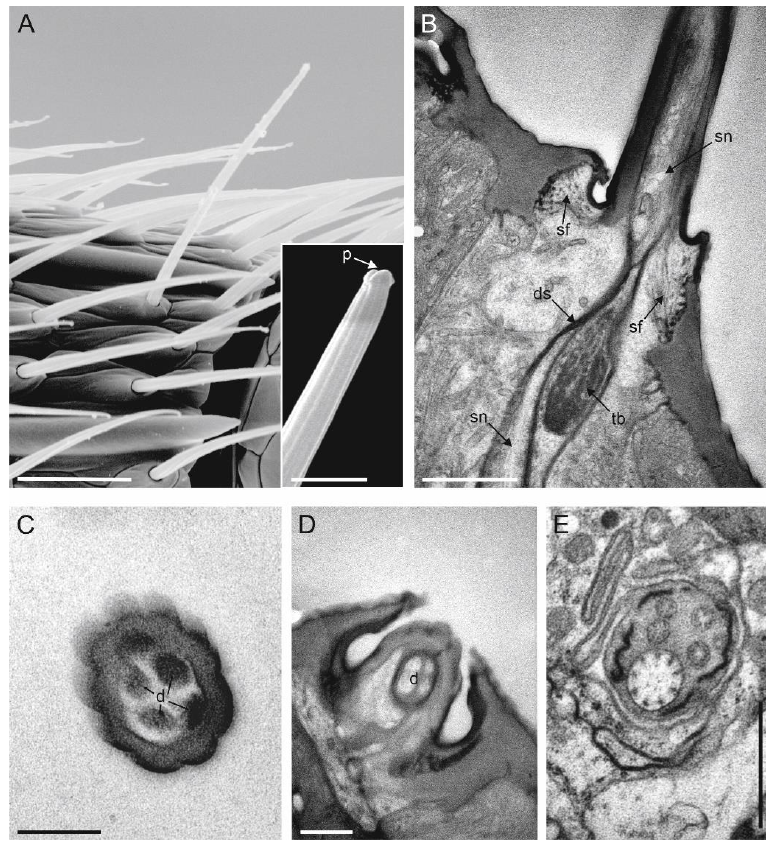
Figure 8. ( A ) Distal region of F6 Anagyrus vladimiri female, with evidence of a single Sensillum Chae- ticum I (SC I) protruding from the surrounding STI. SC I is characterized by a grooved shaft and a single apical pore (p) (inset in ( A )). ( B ) TEM cross-section through the socket of a SC I, showing suspension fibres (sf) at the sensillum base and sensory neurons (sn) innervating the sensillum, surrounded by the dendrite sheath (ds). The sensory neurons enter the cuticular shaft of SC I except for the one ending with the tubular body. ( C – E ) TEM cross-section taken at different levels of an SC I. In ( C , D ), the sections show the dendrites inside the lumen in the medial region of the cuticular shaft ( C ) and close to the base ( D ). In ( E ), the outer dendritic segments are embedded by a discontinuous dendrite sheath. Note the large dendrite belonging to the mechanosensory unit. Scale bar: A: 10 µm; inset in ( A ): 1 µm; ( B , E ): 1 µm; ( C ): 0.25 µm; ( D ): 0.5 µm.